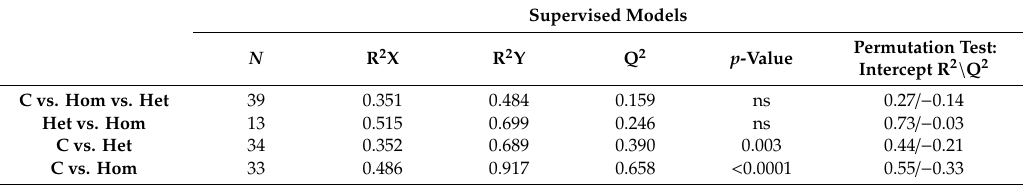
Figure 1. Multivariate statistical models of the di ff erent investigated classes. ( A ) Model with all three group: white circles = Group 1 (control), black boxes = Group 2 (heterozygous for β -thalassemia), and red boxes = Group 3 (homozygous for β -thalassemia). ( B ) Model comparing heterozygous and homozygous for β -thalassemia. ( C ) Model comparing the control group and heterozygous for β -thalassemia. ( D ) Model comparing the control group and homozygous for β -thalassemia. All the statistical parameters of the models are reported in Table 2. Table 2. Summary of the statistical parameters of the multivariate models.